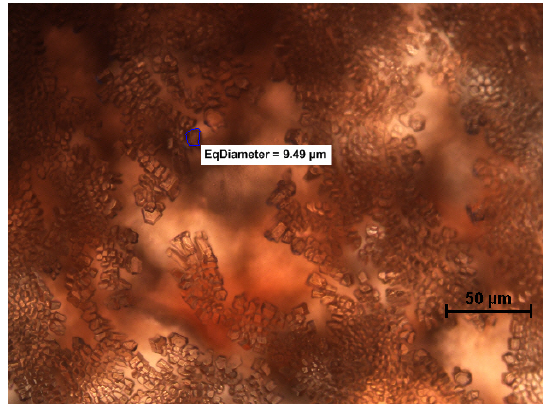
Figure 3. Microscopic image of ice crystals in strawberry sorbet with the addition of AFP III (0.000002%) after one month of storage at −18 °C (own work, not published).